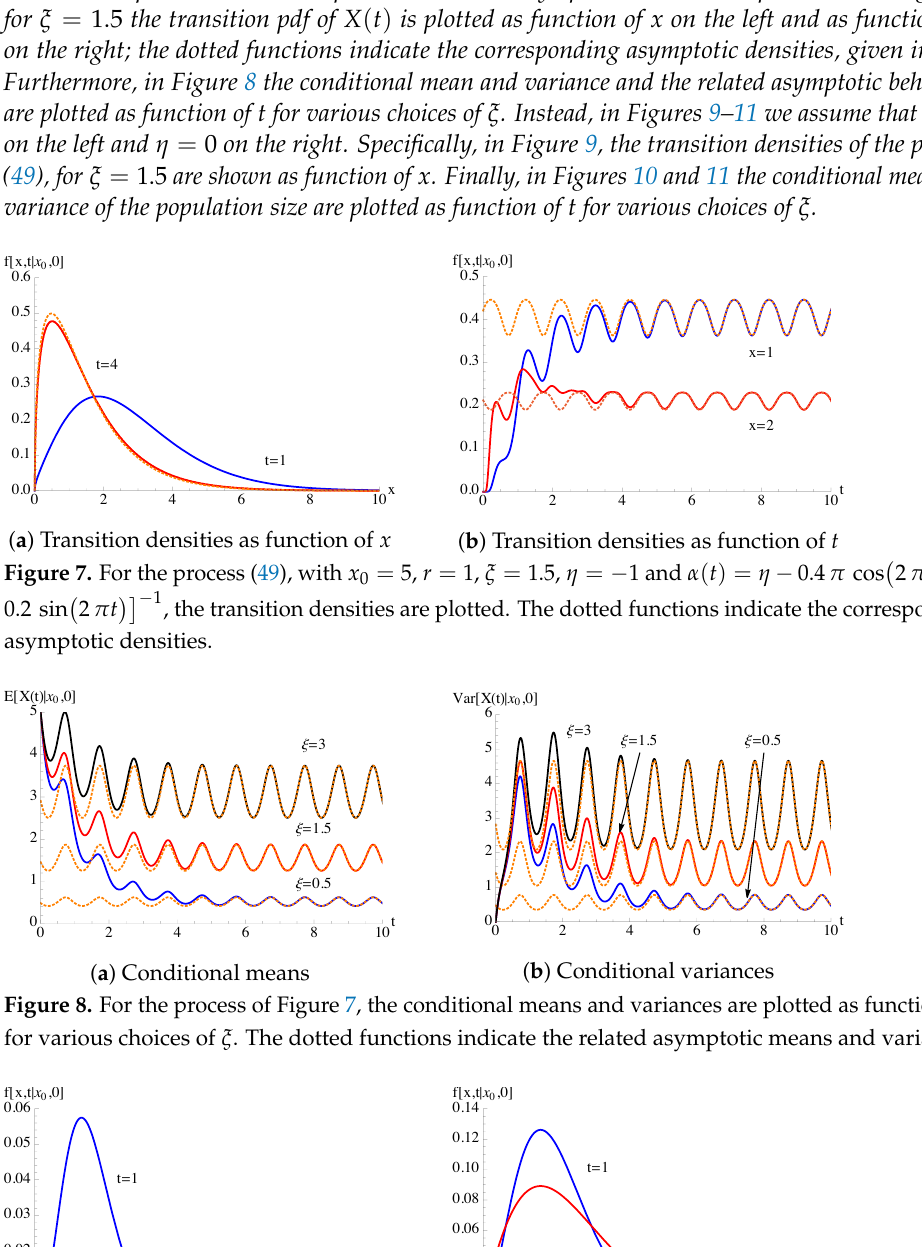
Figure 9. For the process of Figure 7, the transition densities are plotted as function of x